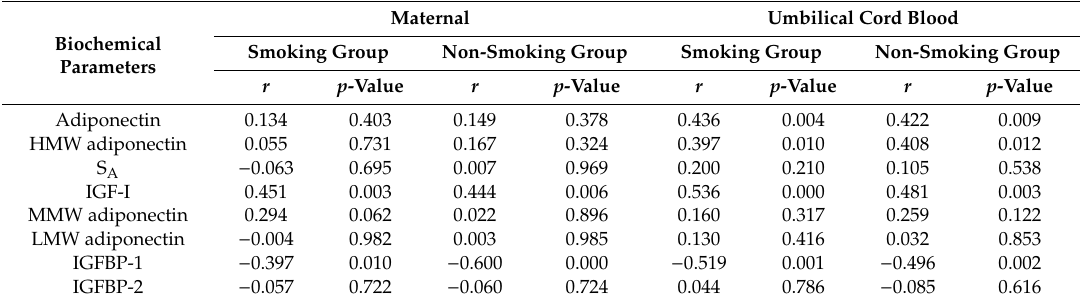
Table 4. Linear relationship between birth weight and studied biochemical parameter levels.